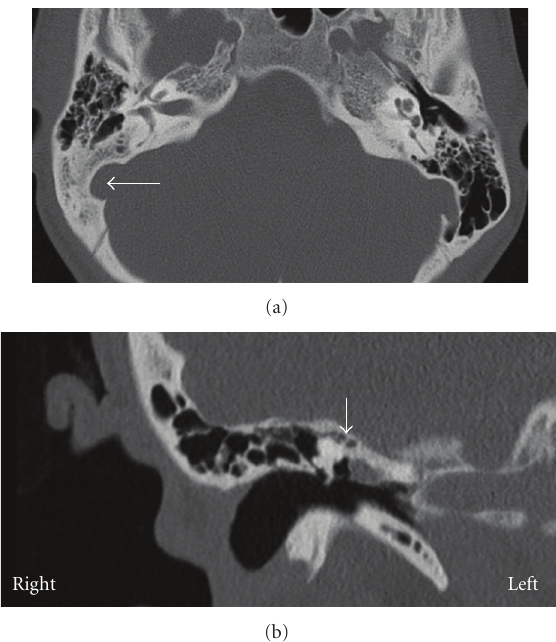
Figure 3: Computed tomography of the temporal bone. (a) Coronal section: lowered pneumatization of the mastoid (long horizontal arrow). (b) frontal section: narrow epitympanum with fixation of the ossicular chain (short vertical